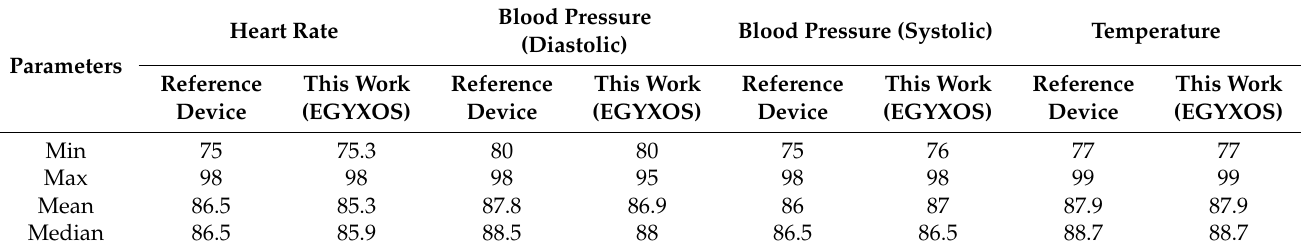
Table 14. The statistical analysis of the average measured data.